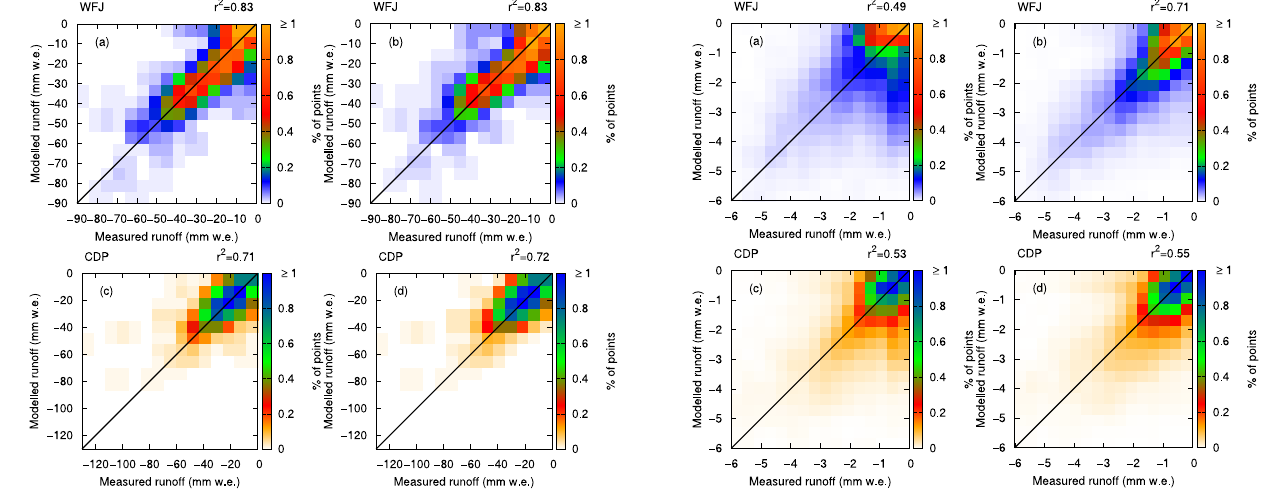
Fig. 7. Density scatter plots for modelled versus measured snow- pack runoff (mm) for the 24h time scale for the bucket scheme (a, c) and RE (Yamaguchi) scheme (b, d) for both WFJ (a, b) and CDP (c, d) . In colour are shown the percentages in the specific region, cut off at 1 %. Data is divided in 15 × 15 bins. For an improved dis- tinction between WFJ and CDP results, the colour scale for CDP is inverted.